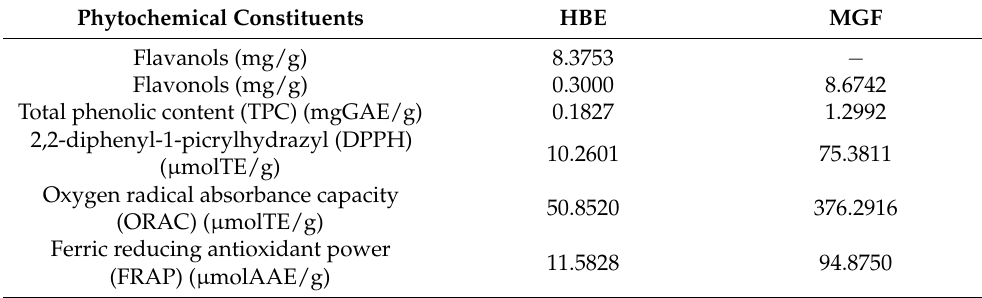
Table 1. Phytochemical analysis and antioxidant capacity of HB extracts (HBE) and mangiferin (MGF). Phytochemical